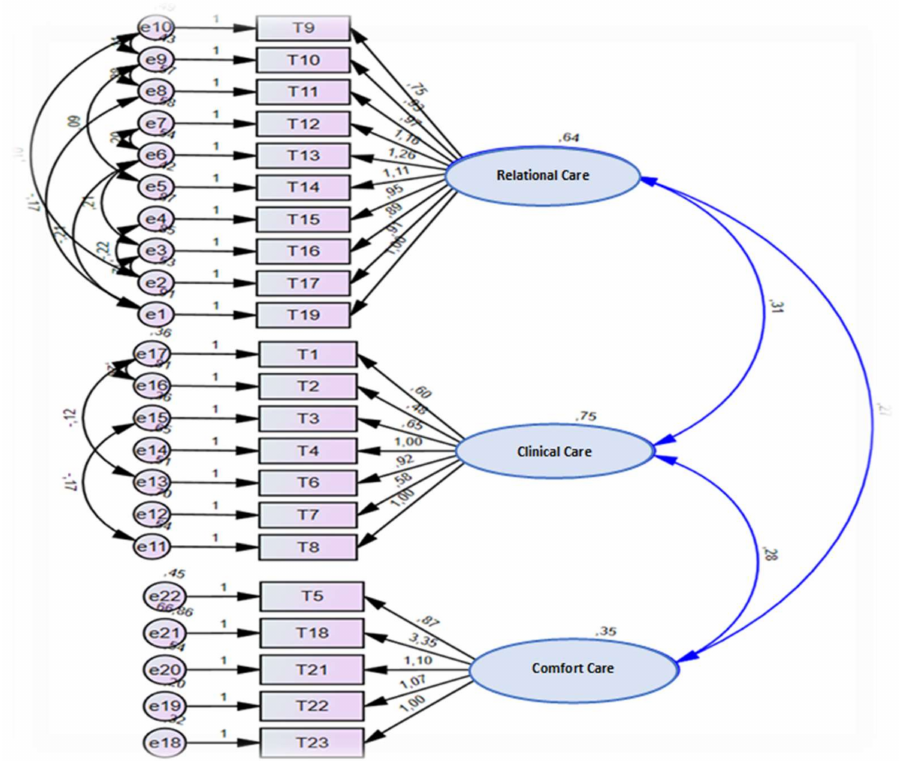
Figure 1. Three-factor model of the nurse-patient interaction scale (EIIP-22 PT) in the hospital care in